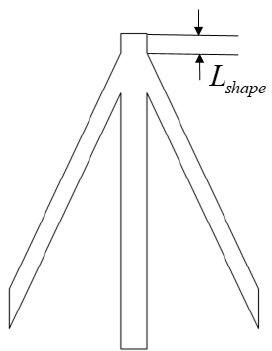
Figure 11. Reasonable honeycomb structure shape.